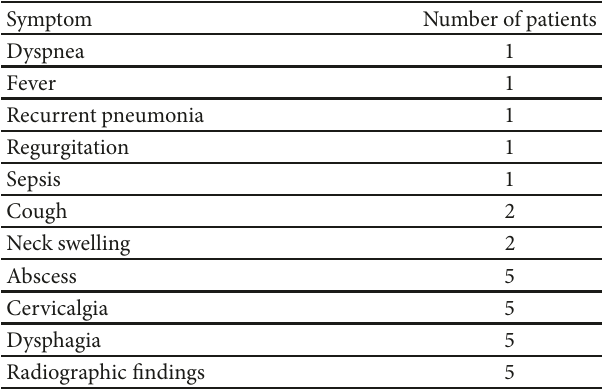
Table 2: Patient symptoms at